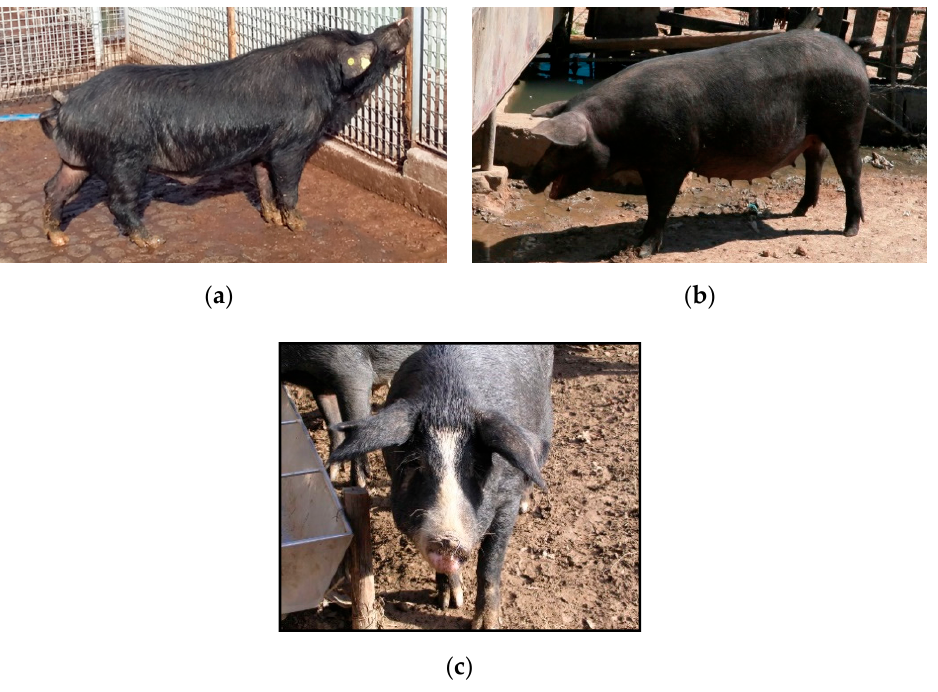
Figure 1. Pigs with different coat colour patterns: Sicilian black sow ( a ), Sicilian black boar ( b ), Facciolo pig ( c ).